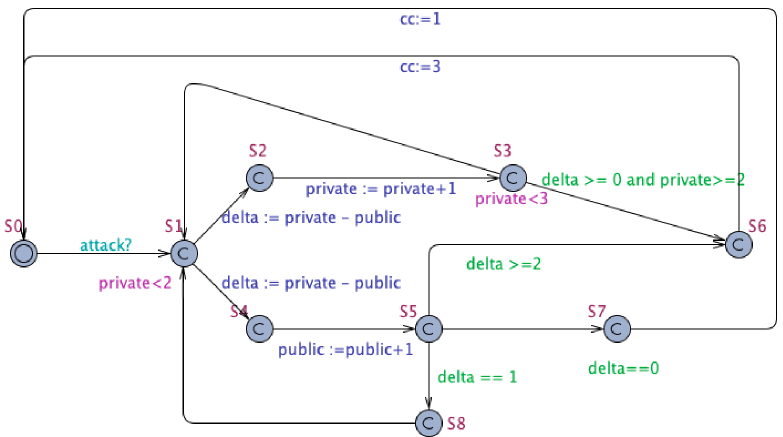
Figure 8. The selfish mining